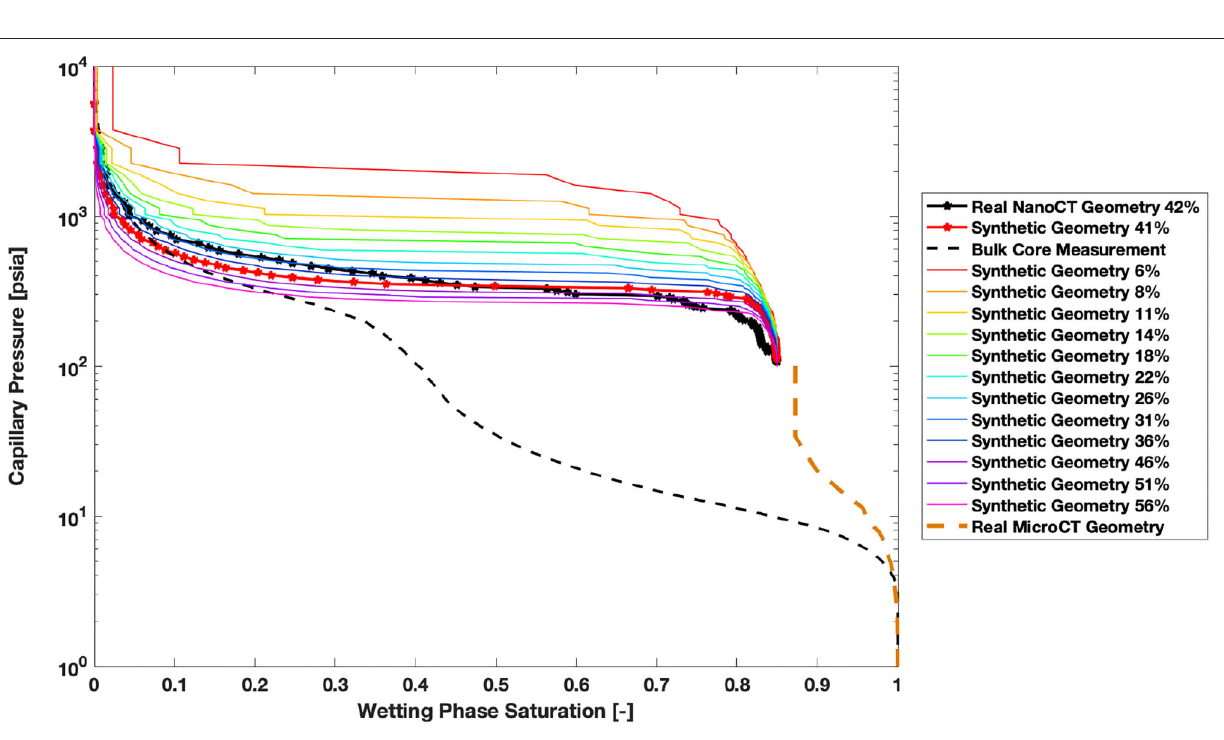
Frontiers in Water |